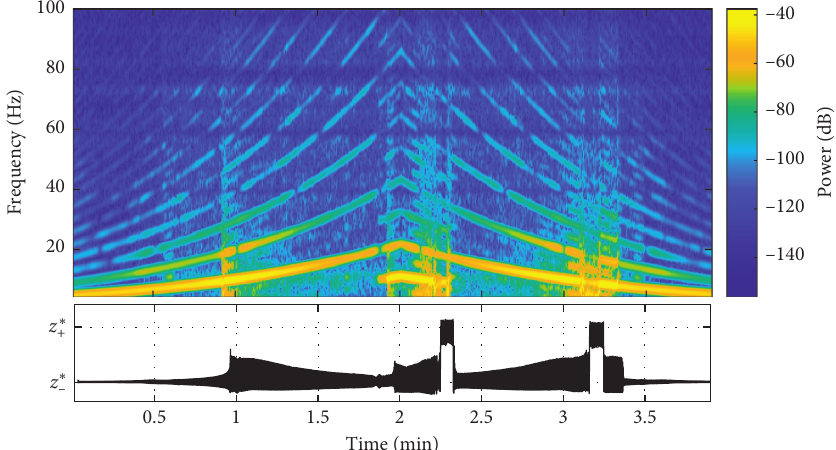
Figure 10: Spectrogram of the highest level sine-sweep test and corresponding time-domain